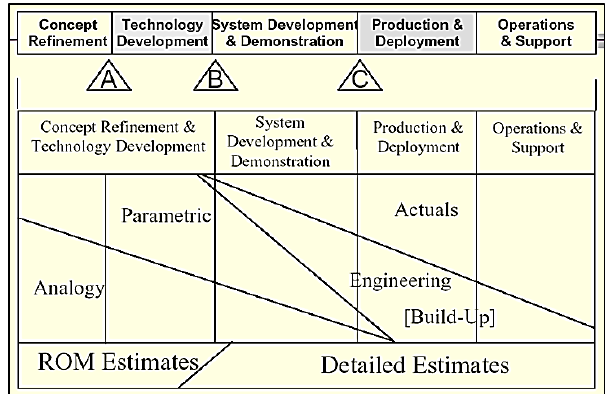
Figure 1 . Typical application of estimating techniques through a system’s life cycle stages [19].